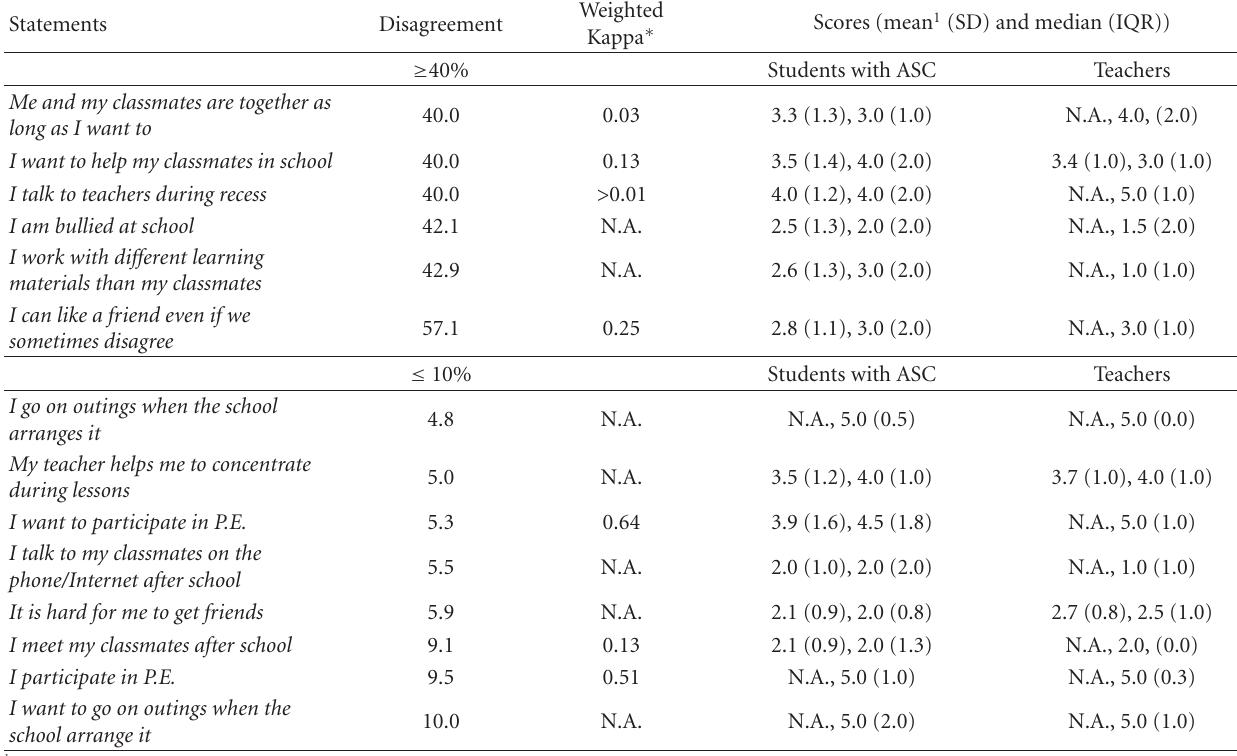
Table 3: The statements on which the students with ASC and the teachers disagreed the most and the least, presented with Weighted Kappa values ∗ , means 1 , standard deviations (SD), medians, and interquartile ranges (IQRs). Not applicable: N.A.